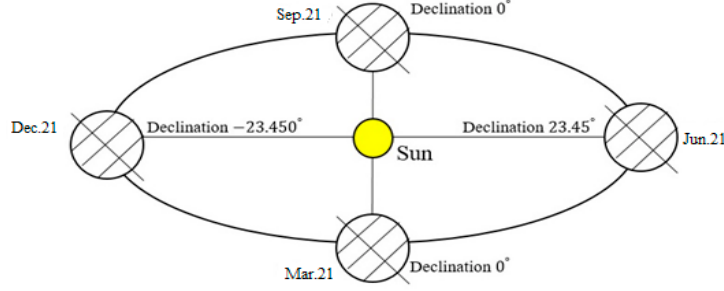
Figure 1. Maximum and minimum value of declination angle.